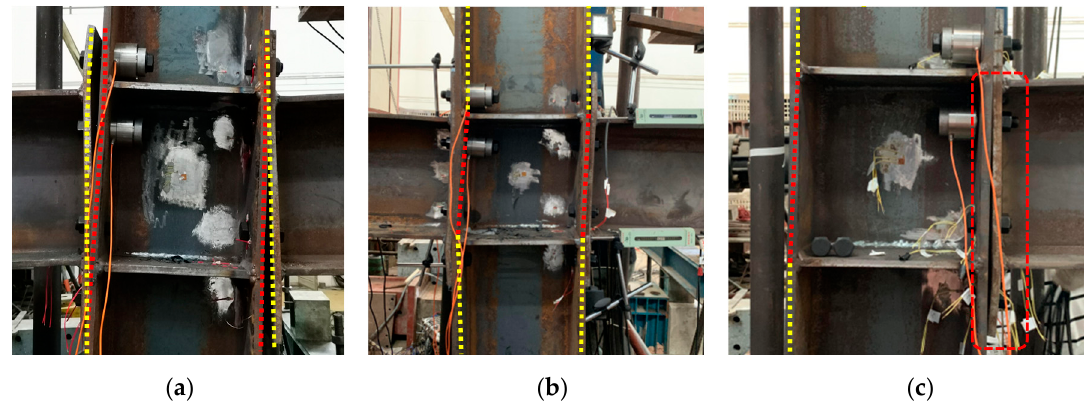
Figure 8. Failure modes of specimens under cyclic loading: ( a ) Specimen IC-EP1; ( b ) Specimen IC-EP2; ( c ) Specimen EC-EP1/EC-EP2. Materials 2020 , 13 , x FOR PEER REVIEW Table 4. Typical failure modes of the bolts.